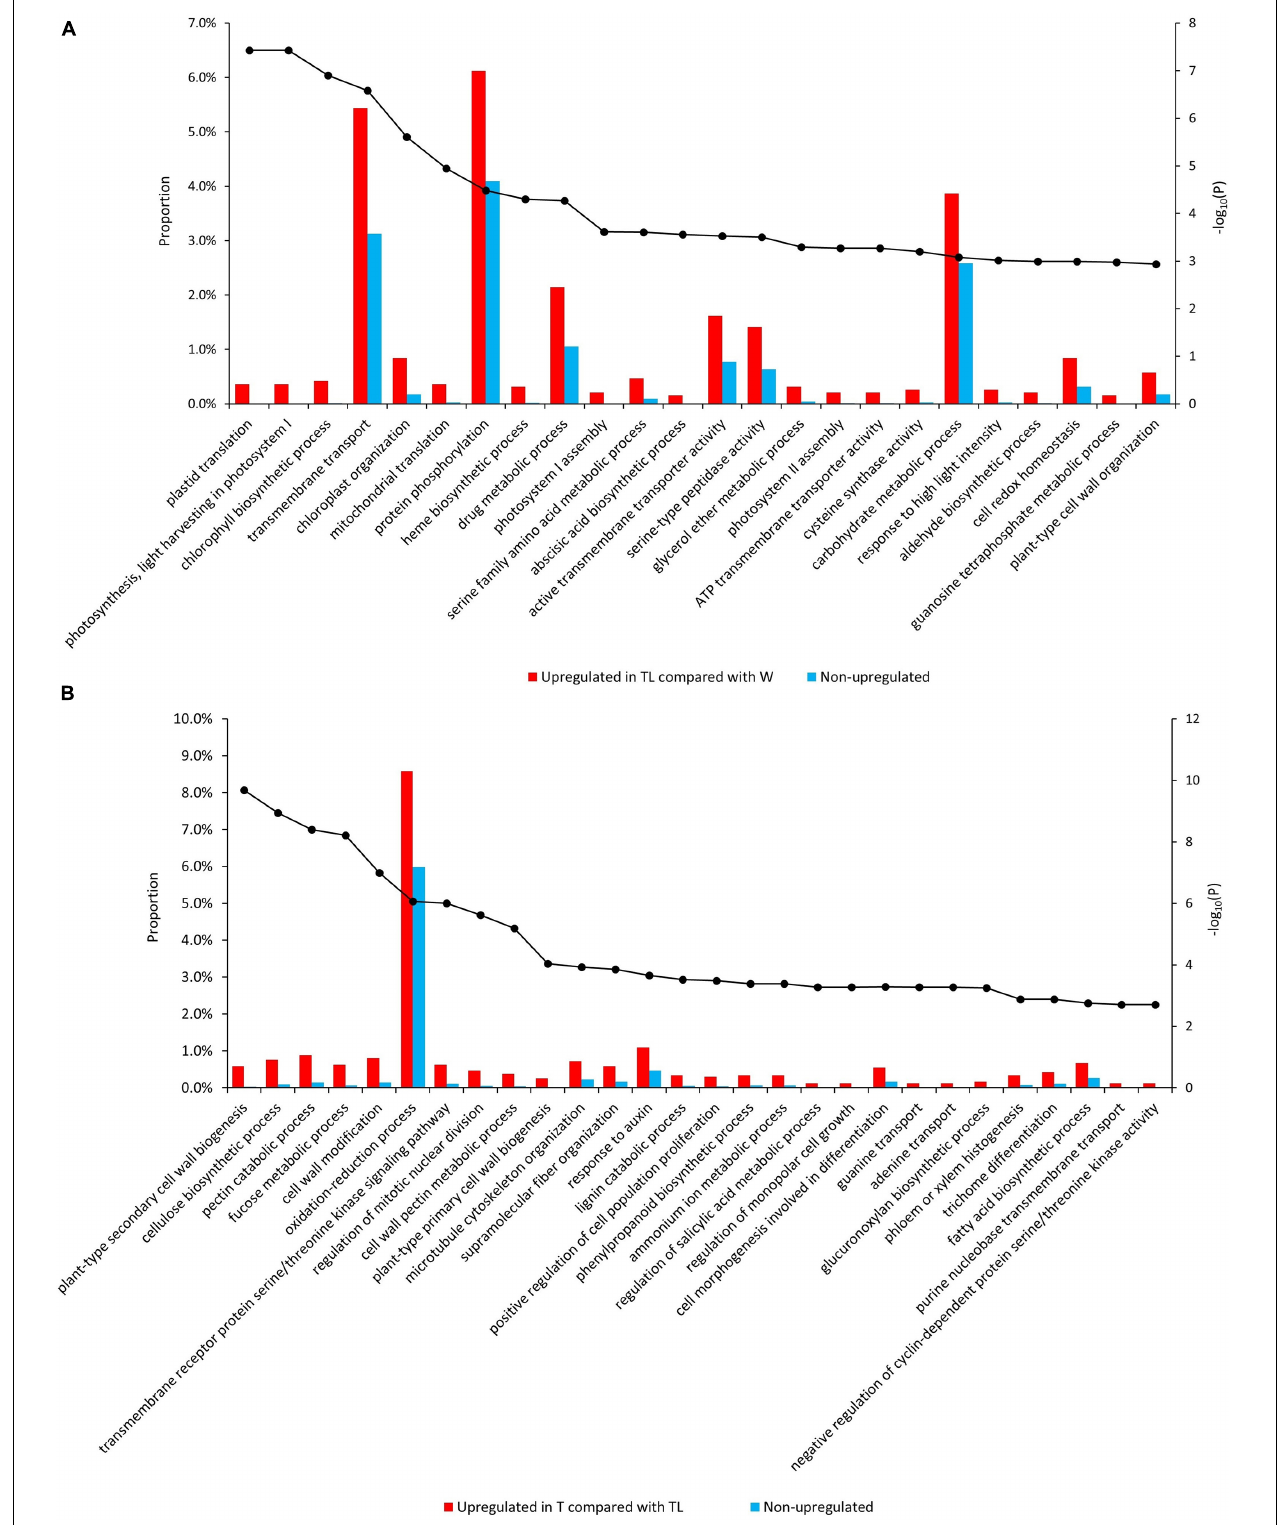
FIGURE 3 | Enriched GO terms from the comparative transcriptomic analysis. Significantly enriched GOs in genes upregulated in TL compared with W (A) and those upregulated in T compared with TL (B) . The bars denote the proportion of genes (the left vertical axis) with each GO in the tested gene sets, and the black dots indicate the –log10 ( p -value of enrichment test) (the right vertical axis) of each GO.